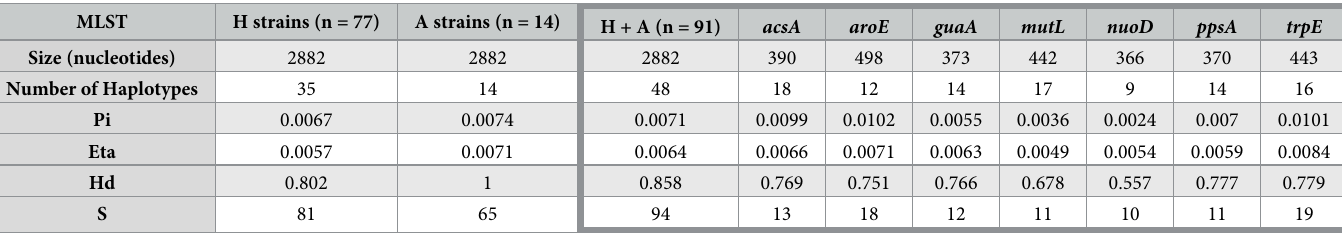
Table 2. Number of haplotypes, nucleotide diversity, gene diversity and substitutions identified by gene for the genotyping of the P . aeruginosa strains via MLST. MLST H strains (n =